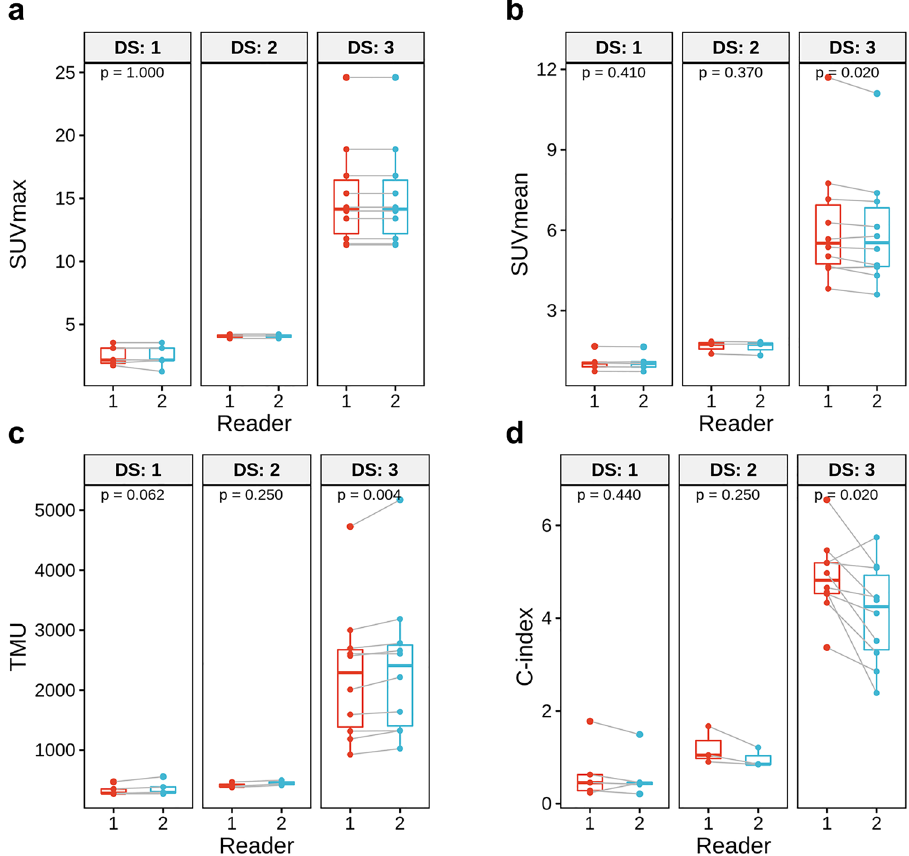
Figure 2. Inter-observer agreement of SPECT/CT indexes from the two readers in each visual grade group. SUVmax showed perfect agreement between the two readers in DS 2 and 3, despite a small difference in DS 1 ( a ), whereas other indexes showed some differences ( b–d ). In particular, C-index in DS 3 showed a significant difference between the two readers ( d ).